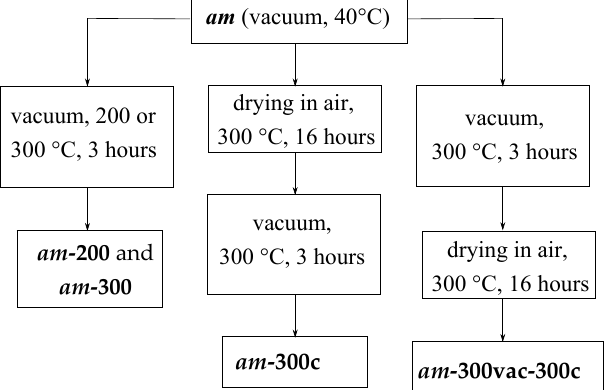
Figure 1. The sequence of heat treatments of samples before N 2 adsorption measurements. NH 3 TPD experiments for the ini -200 , am -200 and am -300 samples were carried out in a flow reactor with on-line signal registration by a thermal conductivity detector. The initial (Na,K form) and ammonia-modified LSX samples were fractionated (size = 0.25–0.5 mm). Then, 100 mg of the sample was mixed with 100 mg of quartz of a similar particle size, loaded into the reactor and pretreated at 200 or 300 °C in a helium flow (50 cm 3 /min) for 2 h to in situ prepare the ini -200 , am -200 and am -300 samples and remove from them any adsorbed water. Here, the heating rate was 100 °C/h. The samples were then cooled to 75 °C, after which, NH 3 was adsorbed by purging the sample with a mixture of ammo- nia (0.35 vol.%) in helium for 1 h. When adsorption was finished, the samples were purged with helium (50 cm 3 /min) for 1 h to remove physically adsorbed ammonia. Finally, the samples were cooled down to room temperature under helium flow. The NH 3 TPD pro- files were recorded by passing helium through the samples at a rate of 30 cm 3 /min accom- panied with heating from 25 to 600 °C at a heating rate of 10 °C/min. The total surface acidity of samples was estimated from the amount of desorbed ammonia molecules, as- suming monodentate ammonia adsorption.